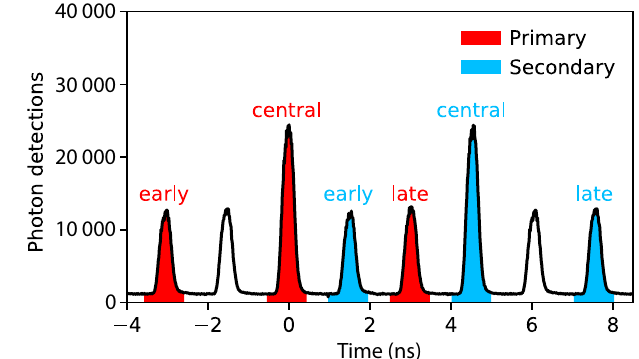
FIG. 2. (a) The setup for time-bin entanglement quantum key distribution with four participants: AM, amplitude modulator; EDFA, erbium-doped fiber amplifier; CIR, circulator; IF, inter- ferometer; SHG, second-harmonic generation; SPDC, sponta- neous parametric down-conversion; AWG, arrayed-waveguide grating; DET, single-photon detector. (b) The setup of the inter- ferometers: BS, 50:50 beam splitter; FRM, Faraday rotator mirror. All interferometers are placed in temperature-stabilized boxes.